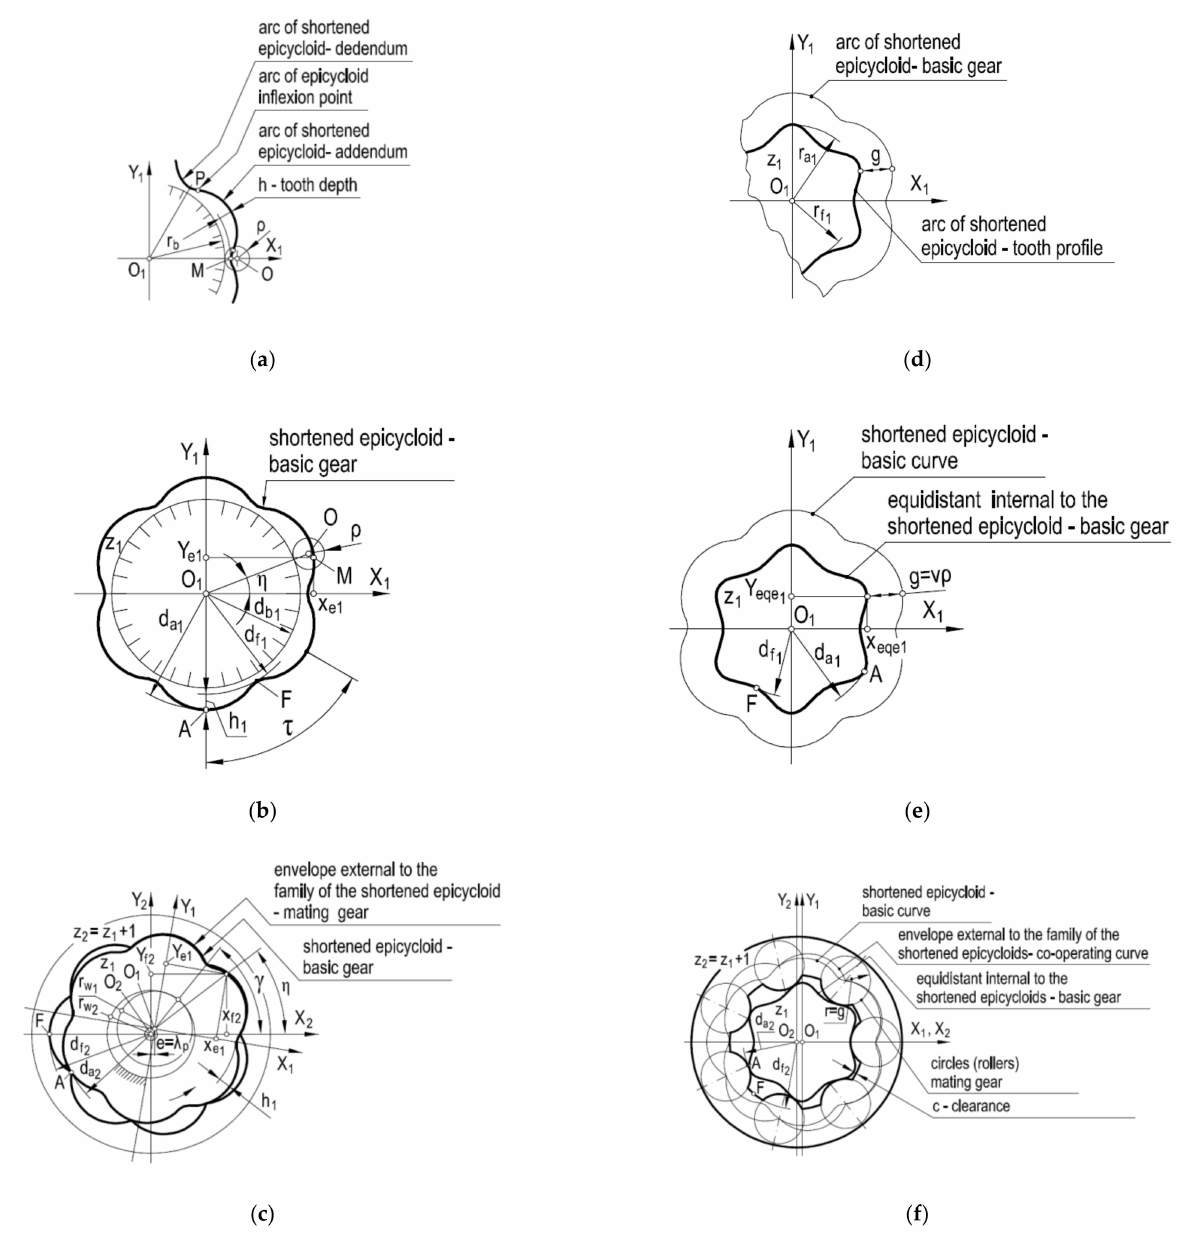
Figure 4. Design of teeth, gears and the internal epicycloidal gear systems: ( a ) uncorrected teeth; ( b ) basic uncorrected external gear; ( c ) mating uncorrected internal gear; ( d ) corrected teeth; ( e ) basic corrected external gear; ( f ) mating internal corrected